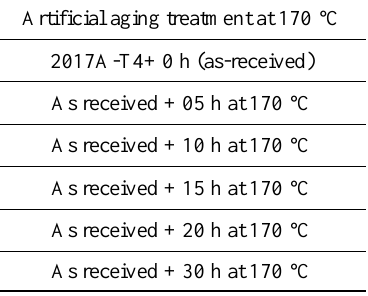
Fig. 1. Geometry and dimensions (in mm) of the tensile samples. Table 2. Artificial aging treatment conditions of 2017A-T4 aluminum